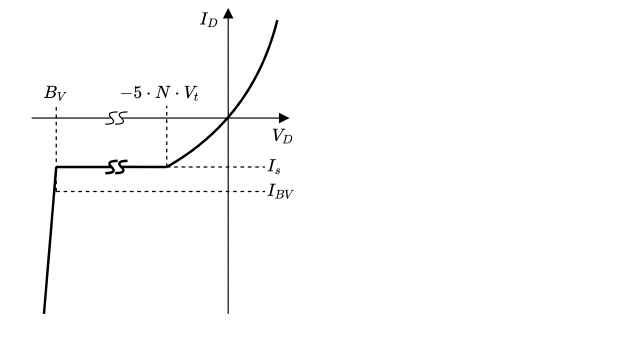
Figure 8. The SPICE large-signal diode model current–voltage characteristics.